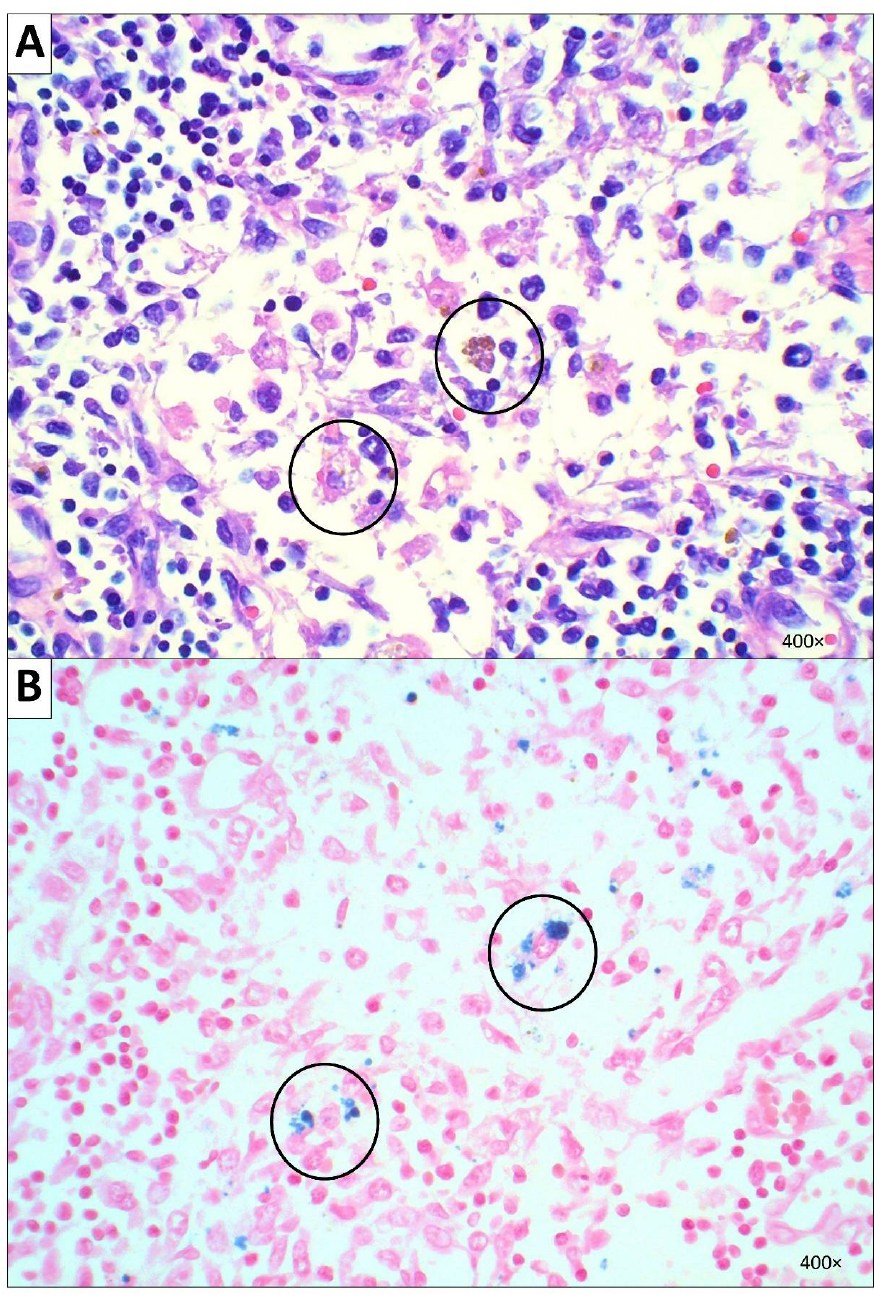
Figure 3. Microscopic image of subcarinal lymph nodes. ( A ) Hemophagocytosis cells with macro- phages engulfing RBCs and hemosiderin are referred to with black circles (H&E, 400× magnifica- tion). ( B ) Hemophagocytosis cells were positive for Prussian blue iron stain (400× magnification).